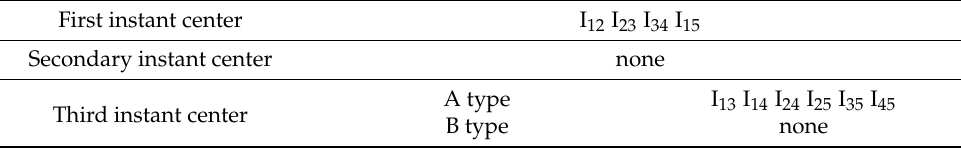
Table 4. Instant centers of five-bar planar linkage with one prismatic